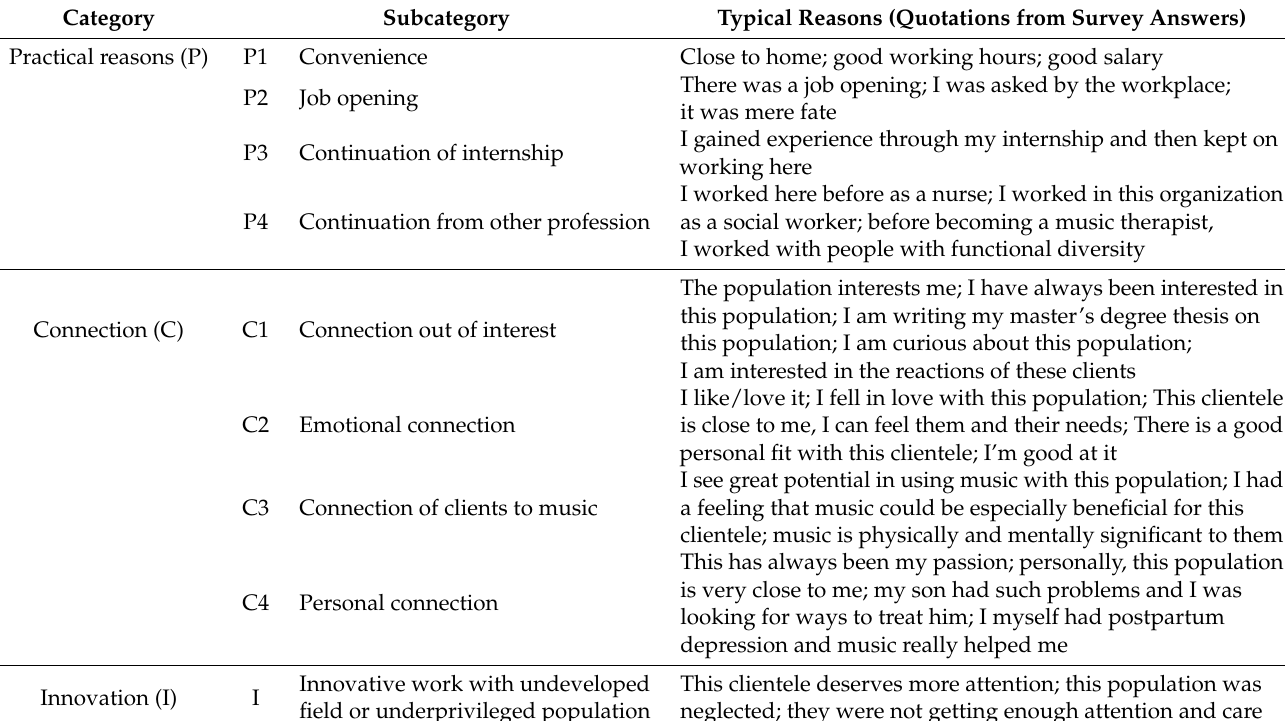
Table 1. Reasons for working with clinical populations—categories, subcategories, and typical